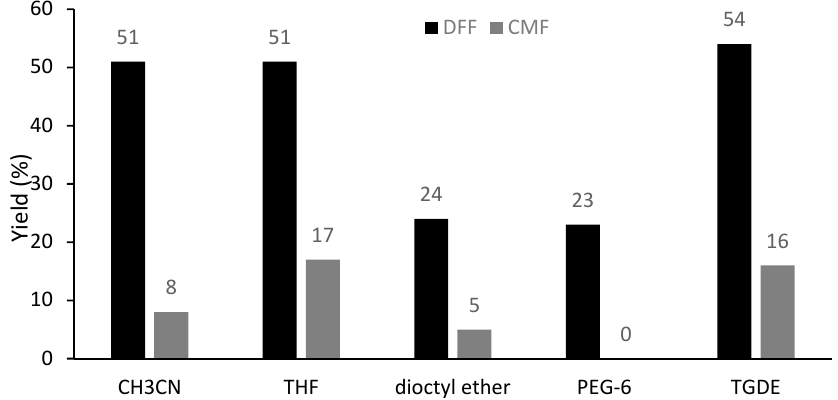
Figure 5. Effect of the solvent on the oxidation of CMF under microwave irradiation (MWI). Reaction conditions : CMF (0.35 mmol, 50 mg), Cu(OTf) 2 (0.5 equiv.), PNO (4 equiv.) in a concentration of 0.5 M at 160 °C for 5 min under MWI; yields were determined by 1 H-NMR analysis of the crude reaction mixture using 1,3,5-trimethoxybenzene as an internal standard.